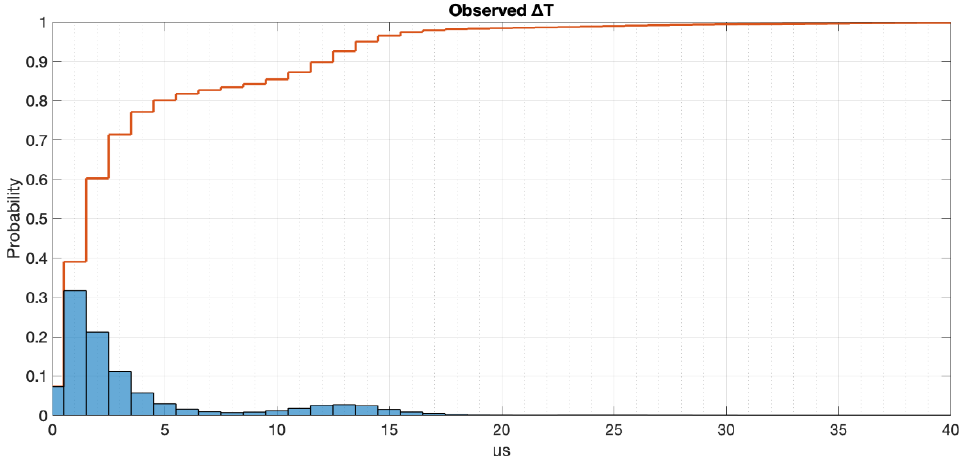
Figure 3. Histogram of the time drifting for both sides of the square wave.